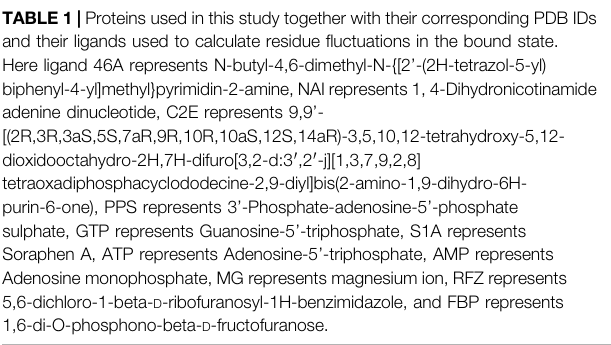
FIGURE 2 | Changes in Fuctuations upon Ligand Binding in (A) UDP-glucose 6-dehydrogenase (PDB ID: 5TJH) bound with uridine-5 ’ -diphosphate-glucose, (B) Citratesynthase(PDBID:4JAF)boundwith1,4-Dihydronicotinamideadeninedinucleotide,and (C) uncharacterizedproteinVCA0042(PDBID:2RDE)boundwith9,9 ’ - [(2R,3R,3aS,5S,7aR,9R,10R,10aS,12S,14aR)-3,5,10,12-tetrahydroxy-5,12-dioxidooctahydro-2H,7H-difuro[3,2-d:3 ’ ,2 ’ -j][1,3,7,9,2,8] tetraoxadiphosphacyclododecine-2,9-diyl]bis(2-amino-1,9-dihydro-6H-purin-6-one).Thegainin fl uctuationsisscaled between0(showninwhite)and1(red),and the loss in fl uctuations is scaled between 0 (yellow) and − 1 (blue). Here, the ligand is in green.